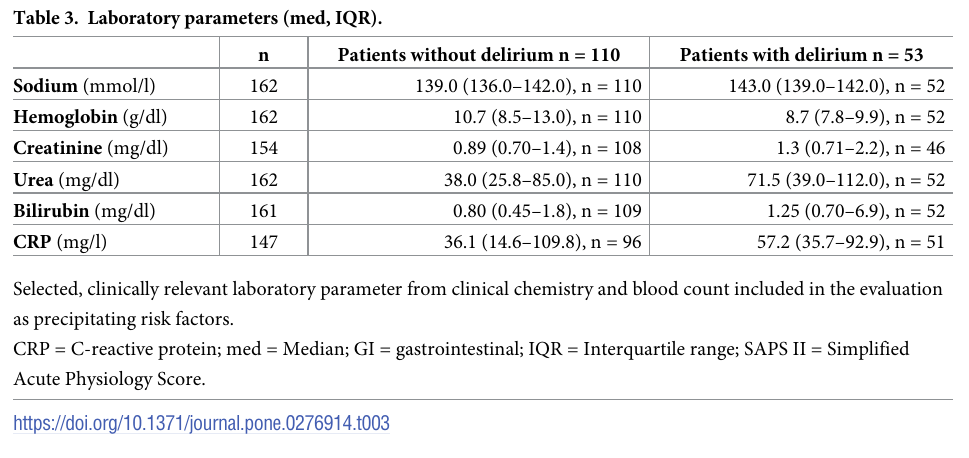
Assessment of Model for End-Stage Liver Disease (MELD) score